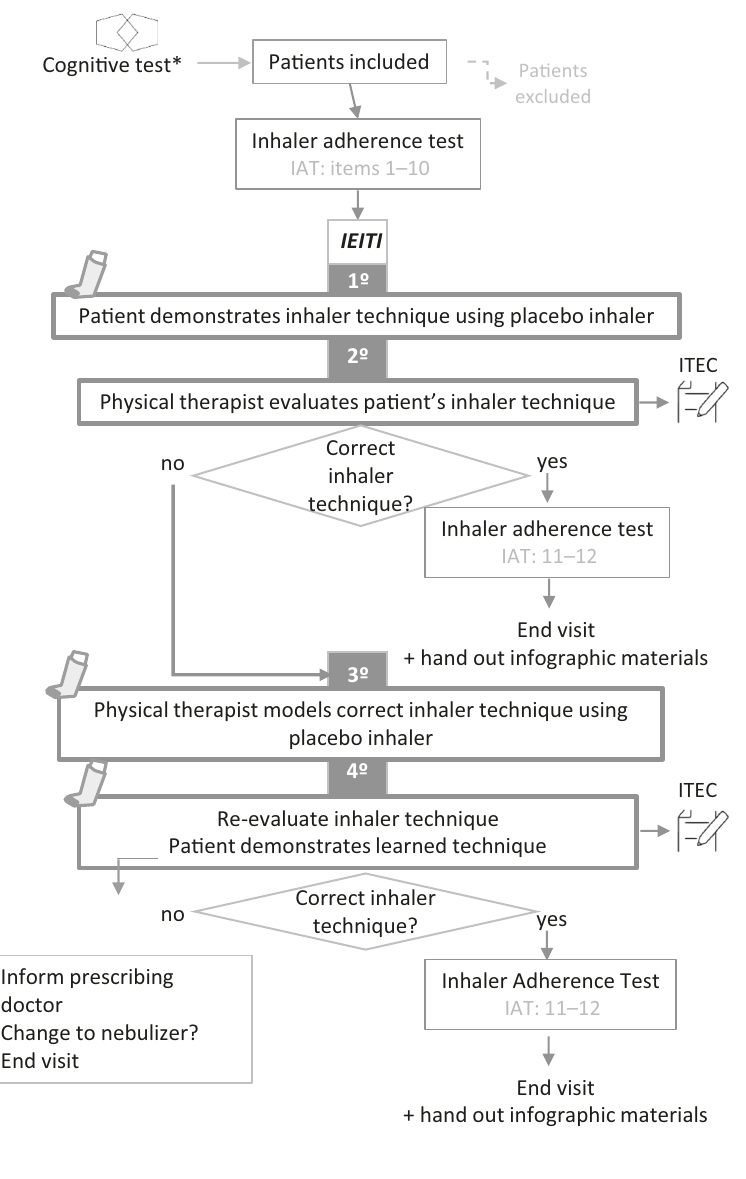
Fig. 2 Individualized educational inhaler technique intervention (IEITI): four